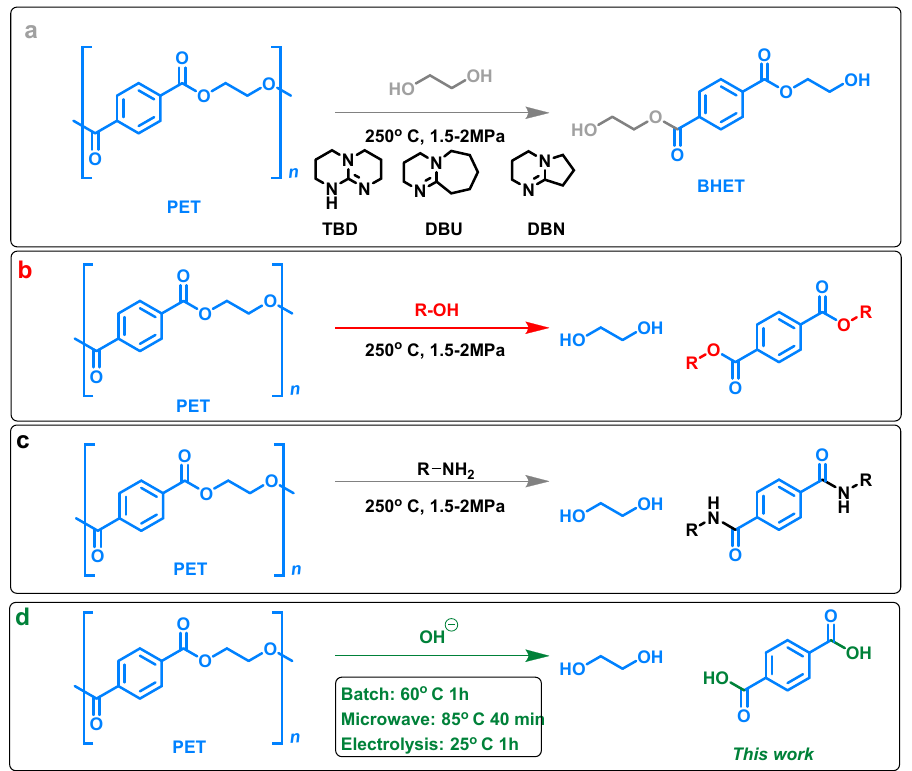
Figure 1. Chemical depolymerization methods for depolymerization of poly(ethylene terephthalate) (PET). ( a ) glycolysis ( b ) alcoholysis ( c ) aminolysis ( d ) chemical depolymerization methods in refluxing methanol and base in batch; at 85 °C in the microwave in 40 min; in an electrolysis experiment at room temperature.